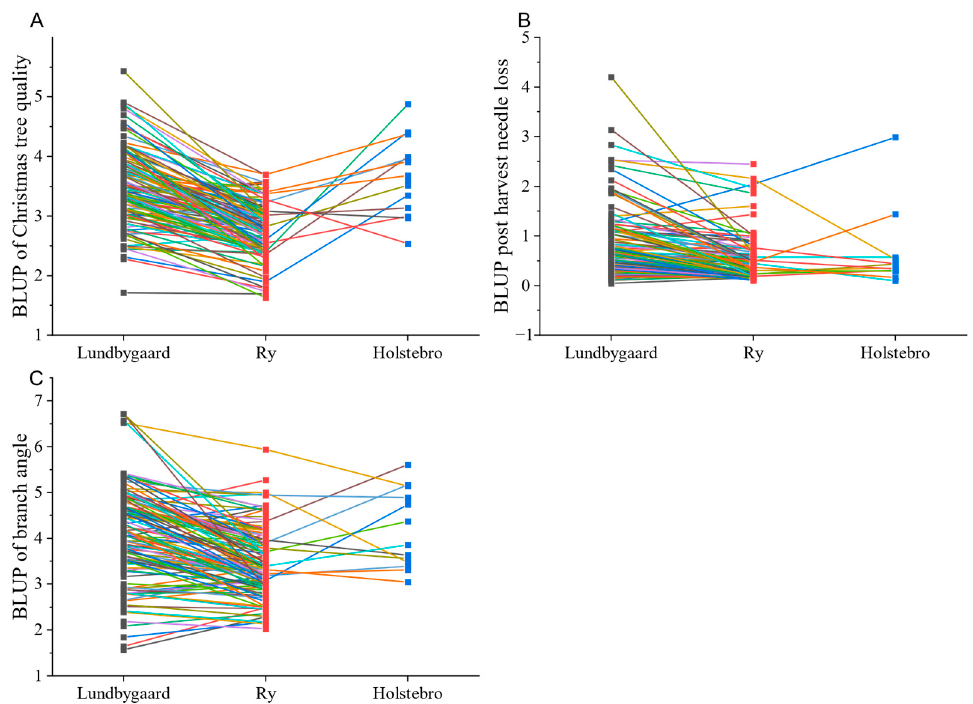
Figure 9. BLUP values for individual clones across sites for traits: ( A ) Christmas tree quality; ( B ) post-harvest needle retention; ( C ) branch angle. Different lines represent different clones.